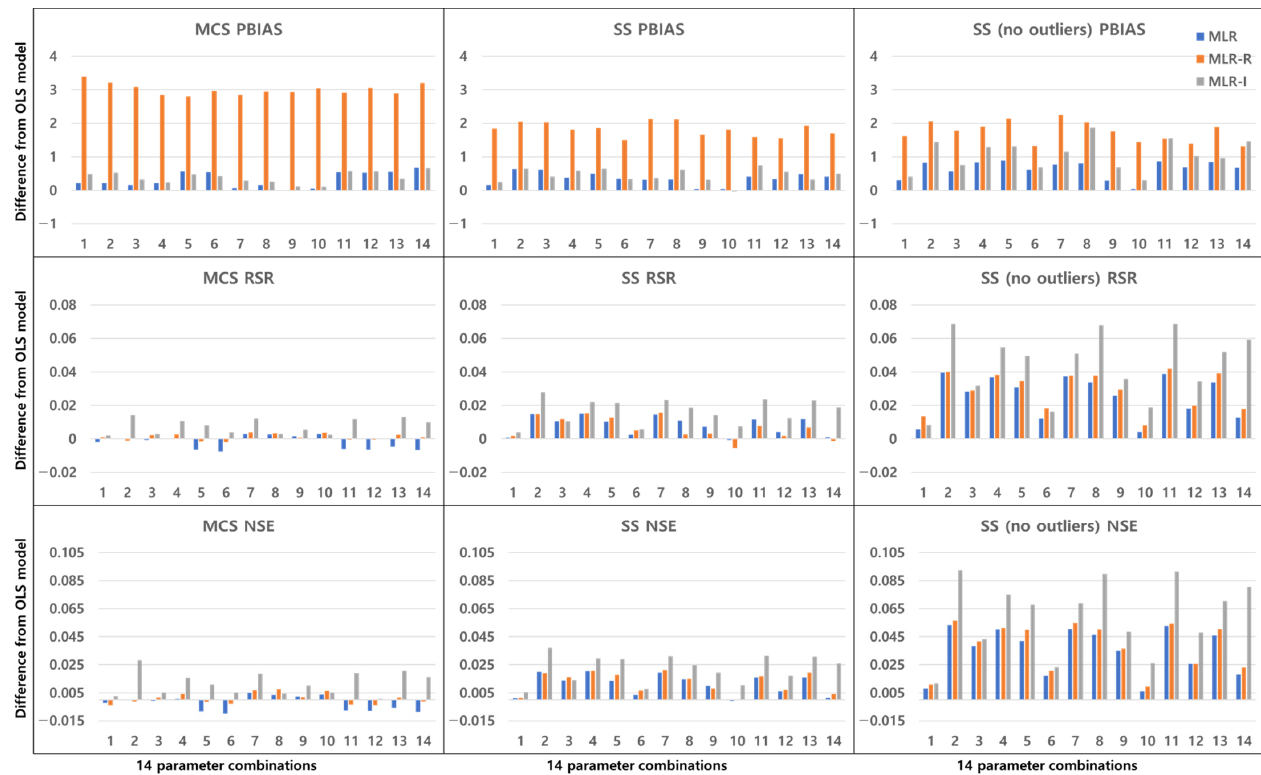
Figure 16. Differences between the OLS model and the other three MLR models by averaging the values of the model evaluations with the three sampling methods for TSS removal in detention basins.